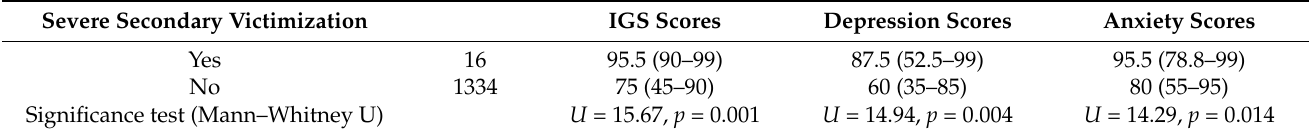
Table 4. Median and quartiles in parentheses for psychopathology scores and severity of secondary victimization. Severe Secondary